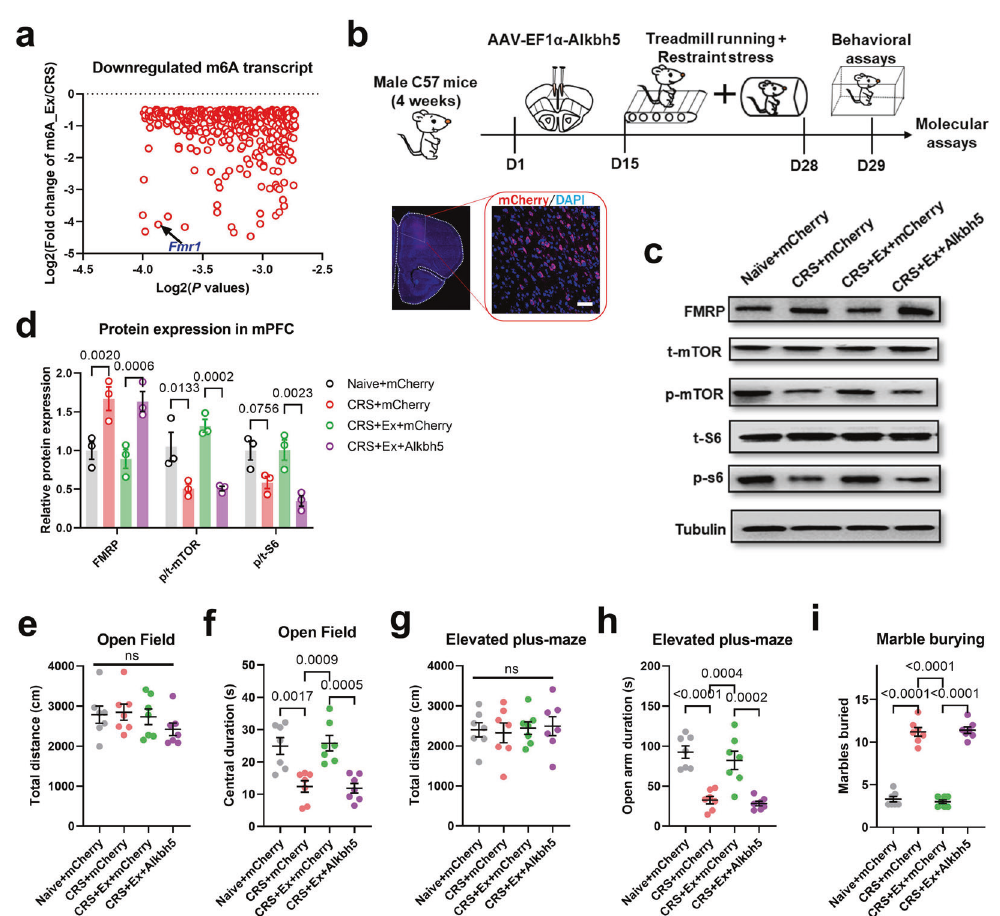
Fig. 7 Exercise-mediated Fmr1 transcript methylation to activate mTOR pathway. a The plotting of exercise-mediated m6A transcript, in contrast with the m6A level in the CRS group. b Experimental design for RNA methylation interference using Alkbh5 gene overexpression. c Representative blotting bands for FMRP, p-mTOR and p-S6. d Quanti fi cation analysis found that blocking RNA methylation in exercised mice elevated FMRP expression and suppressed the mTOR pathway. Multiple t -test was used for comparisons between the two groups. N = 3 mice per group. e Total distance traveled in the open fi eld was unaffected. One-way ANOVA, F (3,24) = 0.9731, P = 0.4217. f Time spent in the central region in the open fi eld was decreased with Alkbh5 gene overexpression. One-way ANOVA, F (3,24) = 13.09, P < 0.0001. g The general locomotor activity on the elevated plus maze was unchanged. One-way ANOVA, F (3,24) = 0.1128, P = 0.9518. h Time duration in the open arm on the elevated plus maze was decreased in CRS + Ex + Alkbh5 group. One-way ANOVA, F (3,24) = 20.14, P < 0.0001. i The number of marbles buried was increased by interfering RNA methylation. One-way ANOVA, F (3,24) = 160.7, P < 0.0001. N = 7 mice in each group in ( e – i ). Tukey ’ s post-hoc test was used for comparisons between the two groups. All data were presented as mean ±